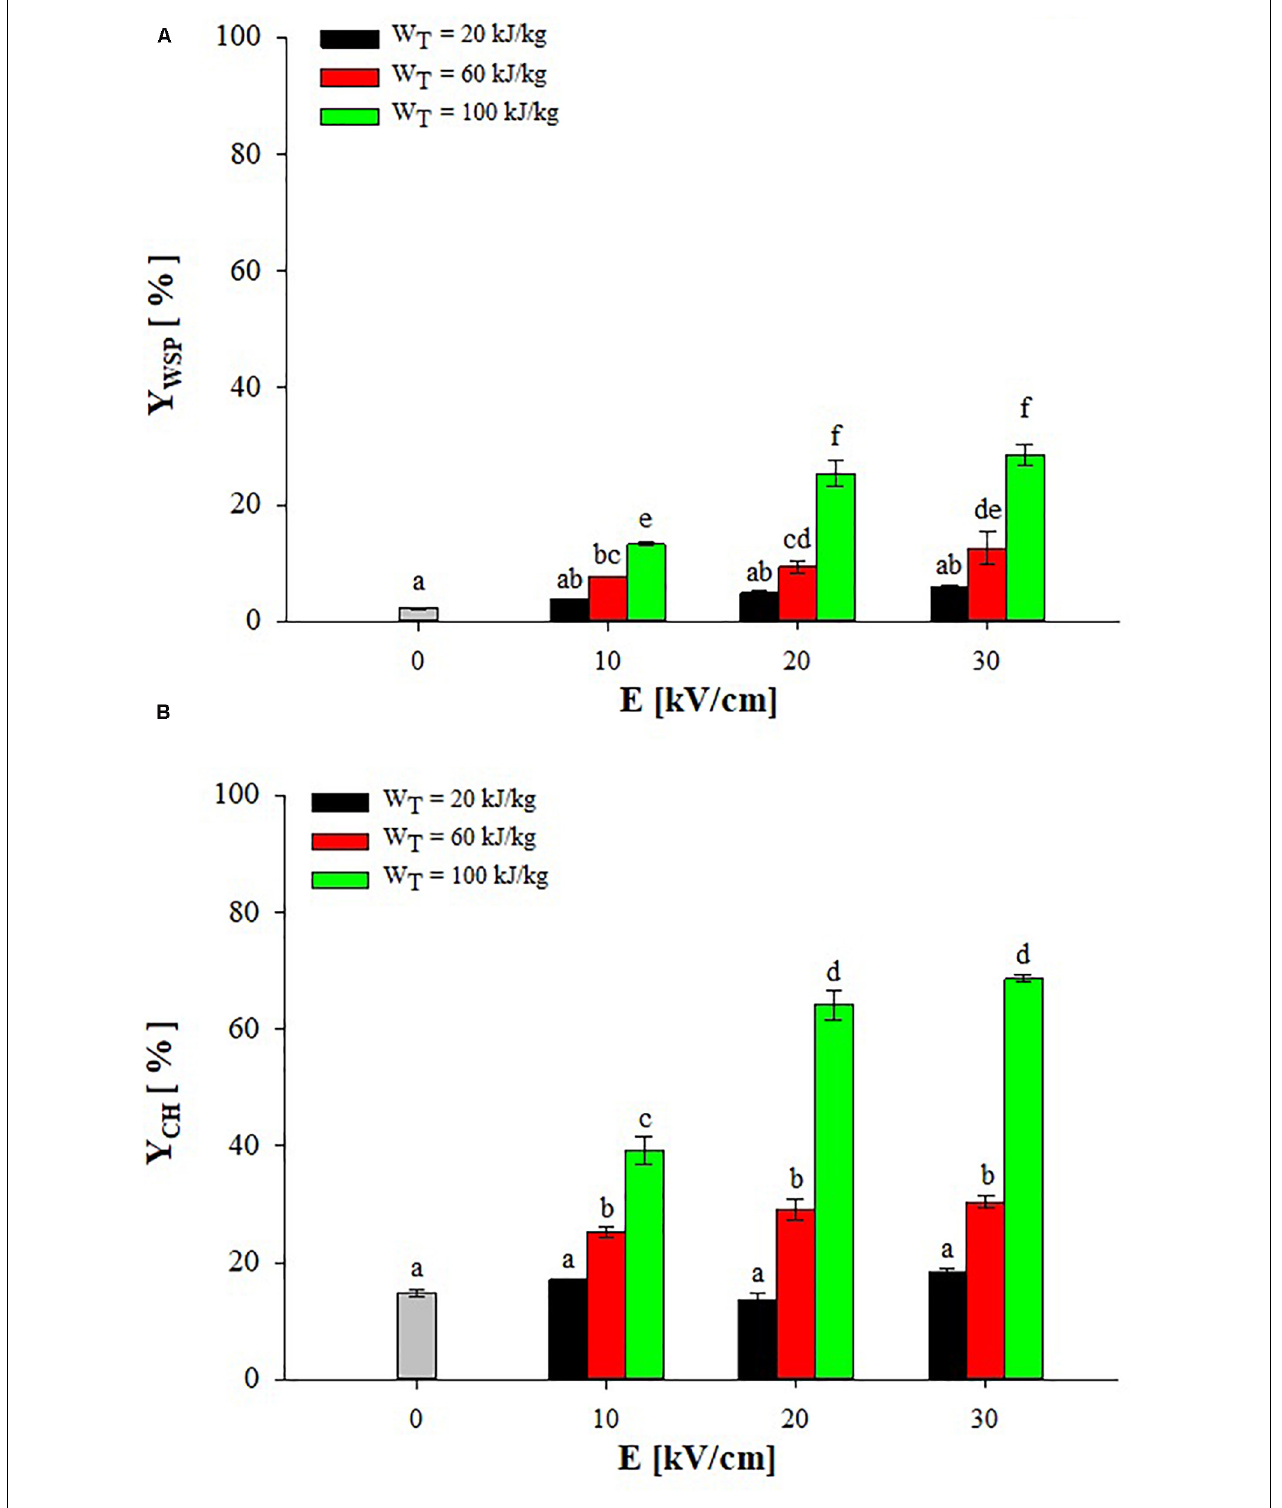
FIGURE 2 | Extraction yield of water-soluble proteins (A) and carbohydrates (B) in the supernatant of untreated (0 kV/cm) and PEF (T IN = 25 ◦ C) treated A. platensis suspension 3 h after treatment as a function of the field strength and for different energy input. The yields were calculated considering 100% extraction yield upon the HPH treatment ( P = 150 MPa, n P = 3). Different letters above the bars indicate significant differences among the mean values of the samples ( p ≤ 0.05).